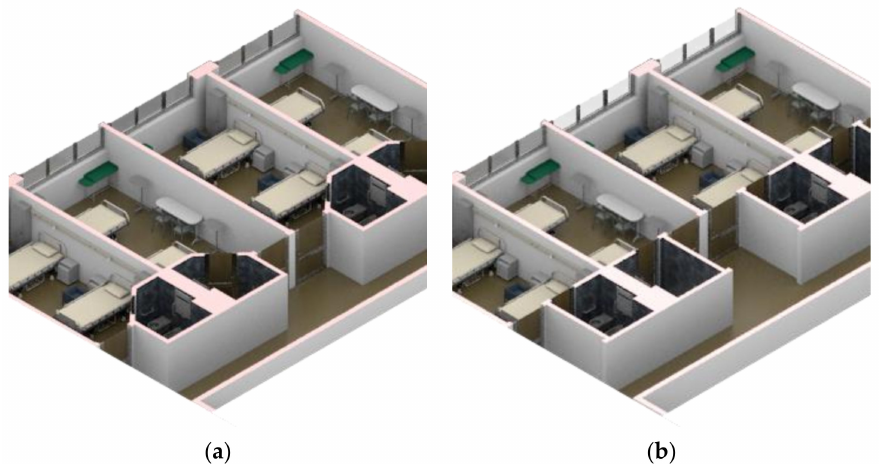
Figure 13. The two alternatives of access space to the bedrooms: on the left, in the original configura- tion ( a ) and on the right, in the modified configuration, with the different shape of the room access space ( b